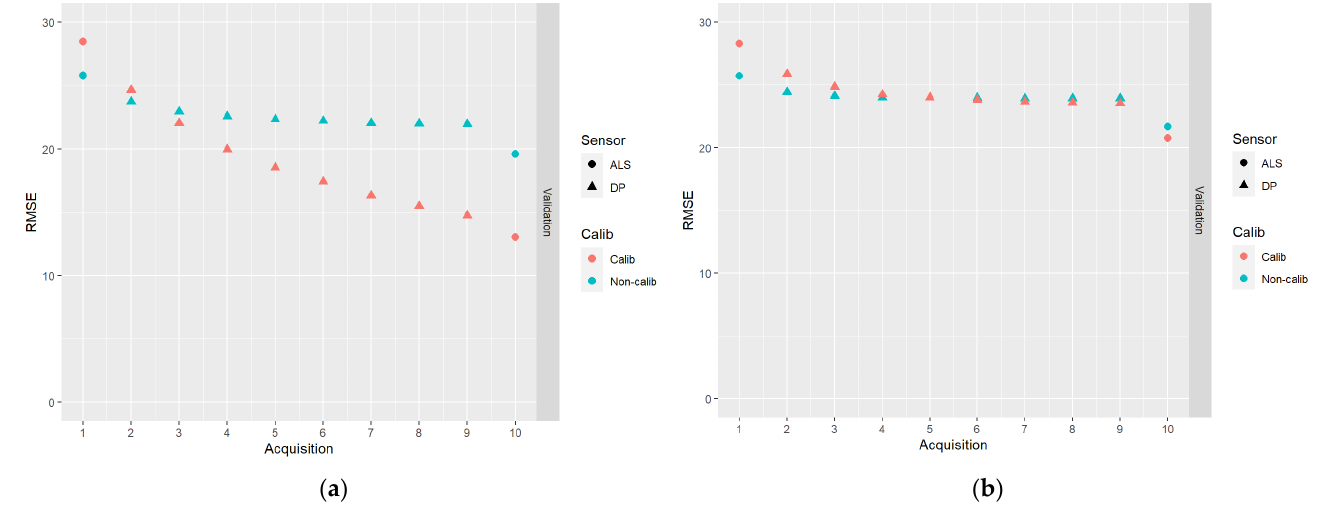
Figure 8. The results of DA schemes based on the first acquisition of ALS data, followed by eight acquisitions of DP data, and ending with an ALS acquisition: ( a ) no correlations between model errors were simulated (case I); ( b ) correlations were simulated according to Table 2 (case II).